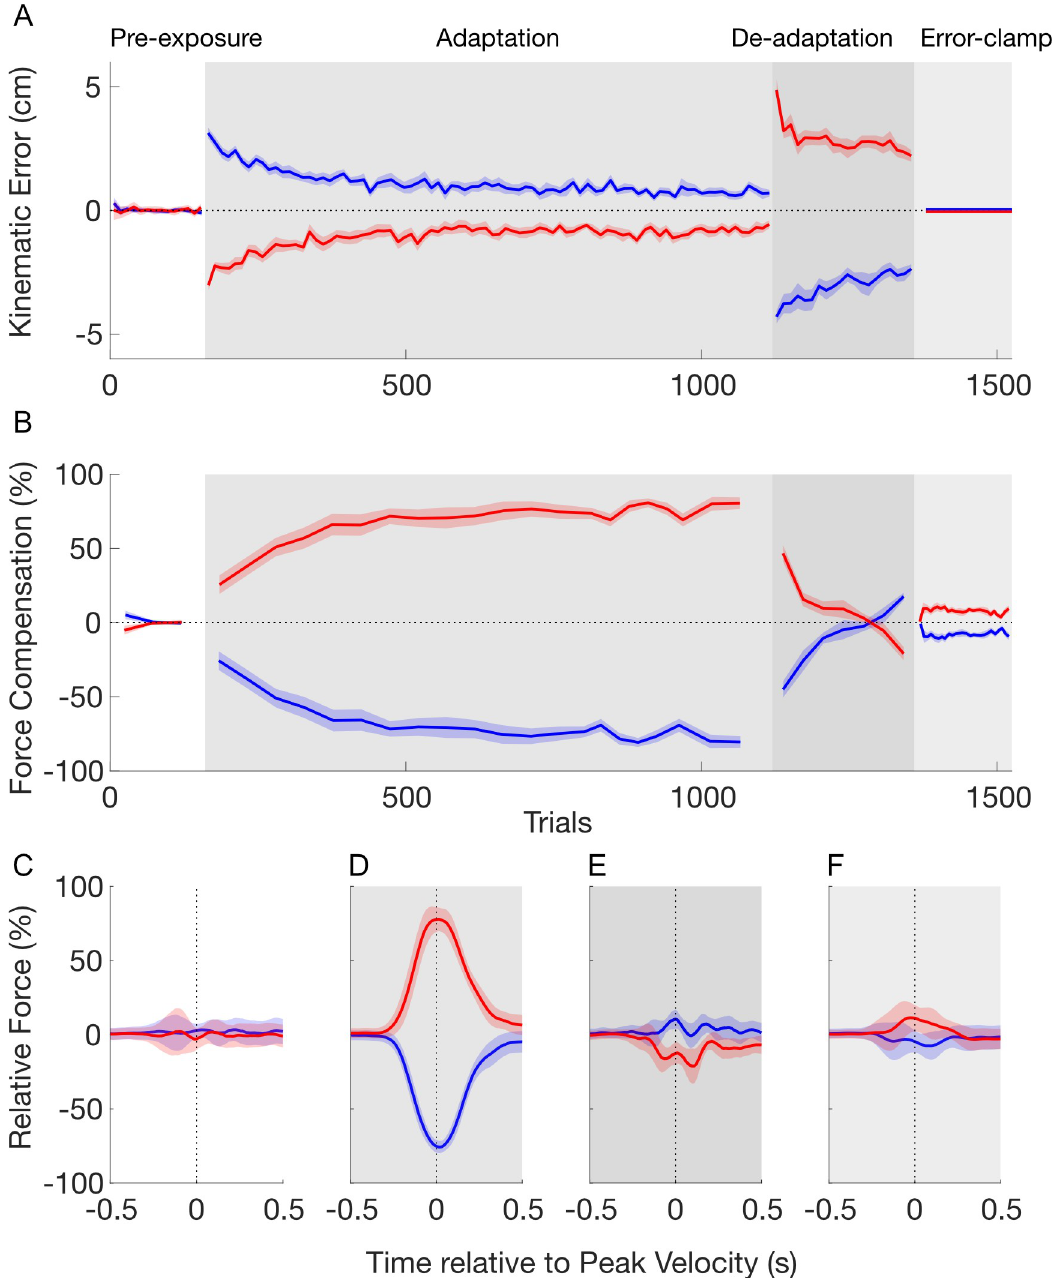
Fig 6. Temporal pattern of adaptation to opposing force fields in experiment 2. Plotted as experiment 1. A. Mean of kinematic error over pre-exposure (white), adaptation (grey), de-adaptation (dark grey) and error-clamp (light grey) phases. B. Mean of force compensation. C. Force profiles on the channel wall as a function of movement time in the pre-exposure phase. D. Force profiles in the adaptation phase. E. Force profiles in the de-adaptation phase F. Force profiles for all trials in the error-clamp phase. plateauing around 80%. A post hoc comparison showed an increase in force compensation between pre-exposure and final adaptation phases (post hoc comparisons: p < 0.001). The force profiles at the end of adaptation exhibit a bell-shaped profile (Fig 6D) indicating predictive compensation for both of the velocity-dependent curl force fields.